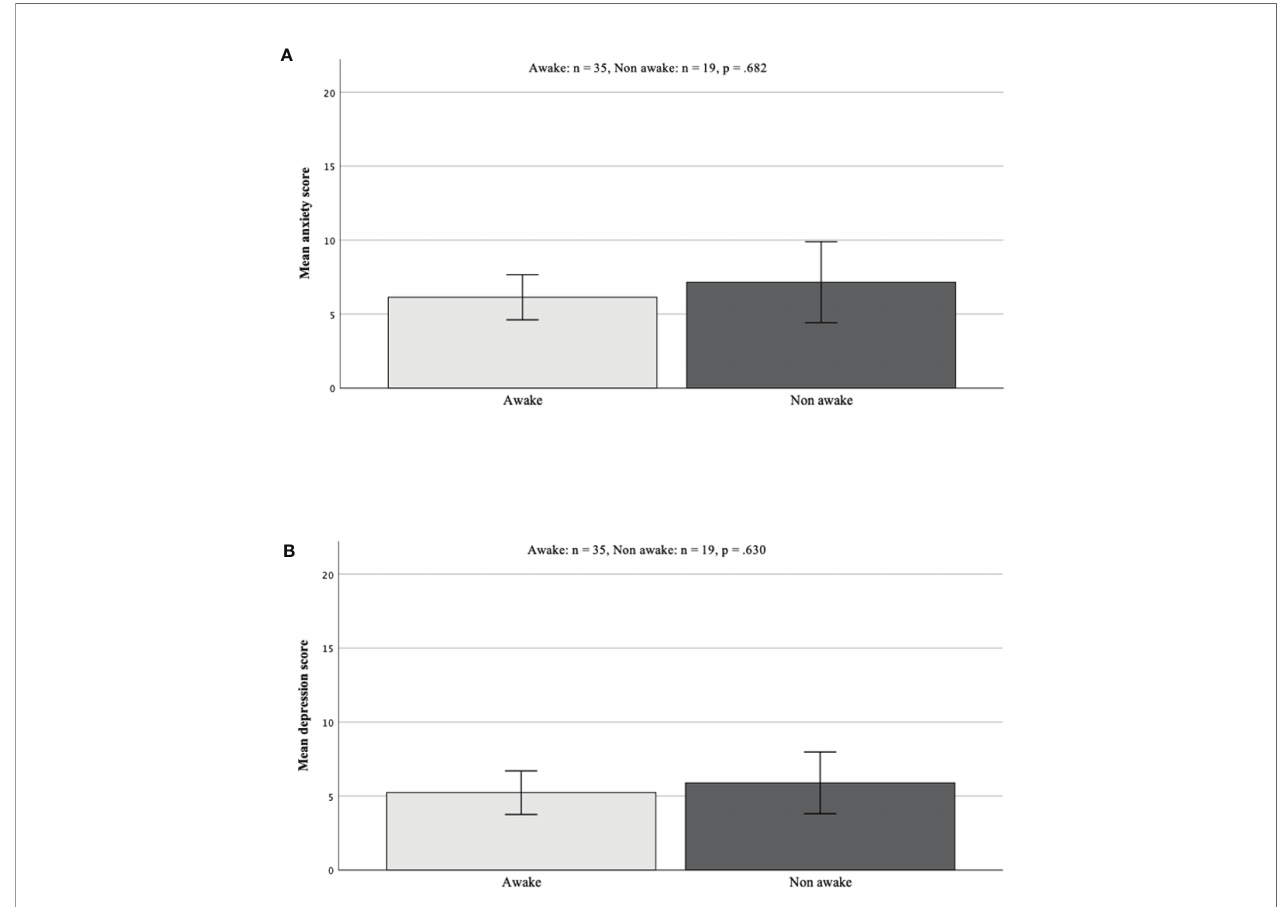
FIGURE 3 | (A, B) Group comparison of scores in HADS screening. Results did not differ signi fi cantly [awake vs. GA anxiety scores p = 0.682 (A) ; depression scores p = 0.630 (B) ]. HADS, Hospital Anxiety and Depression Scale; GA, general